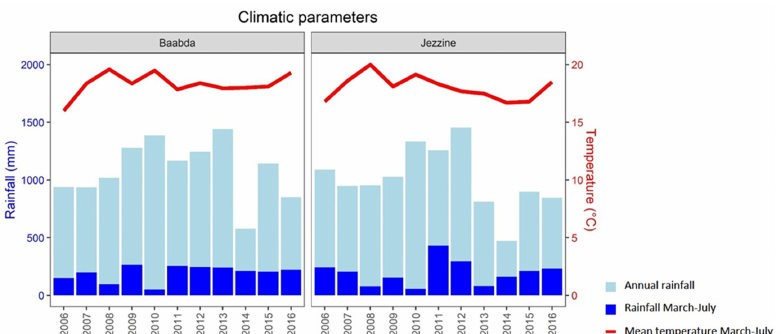
Figure 2. Averages of mean annual rainfall (mm), growing season and cone initiation (March–July), rainfall (mm) and temperature (°C) from 2006 to 2016. Reference: Department of Meteorology— General Direction of Civil Aviation in Lebanon.